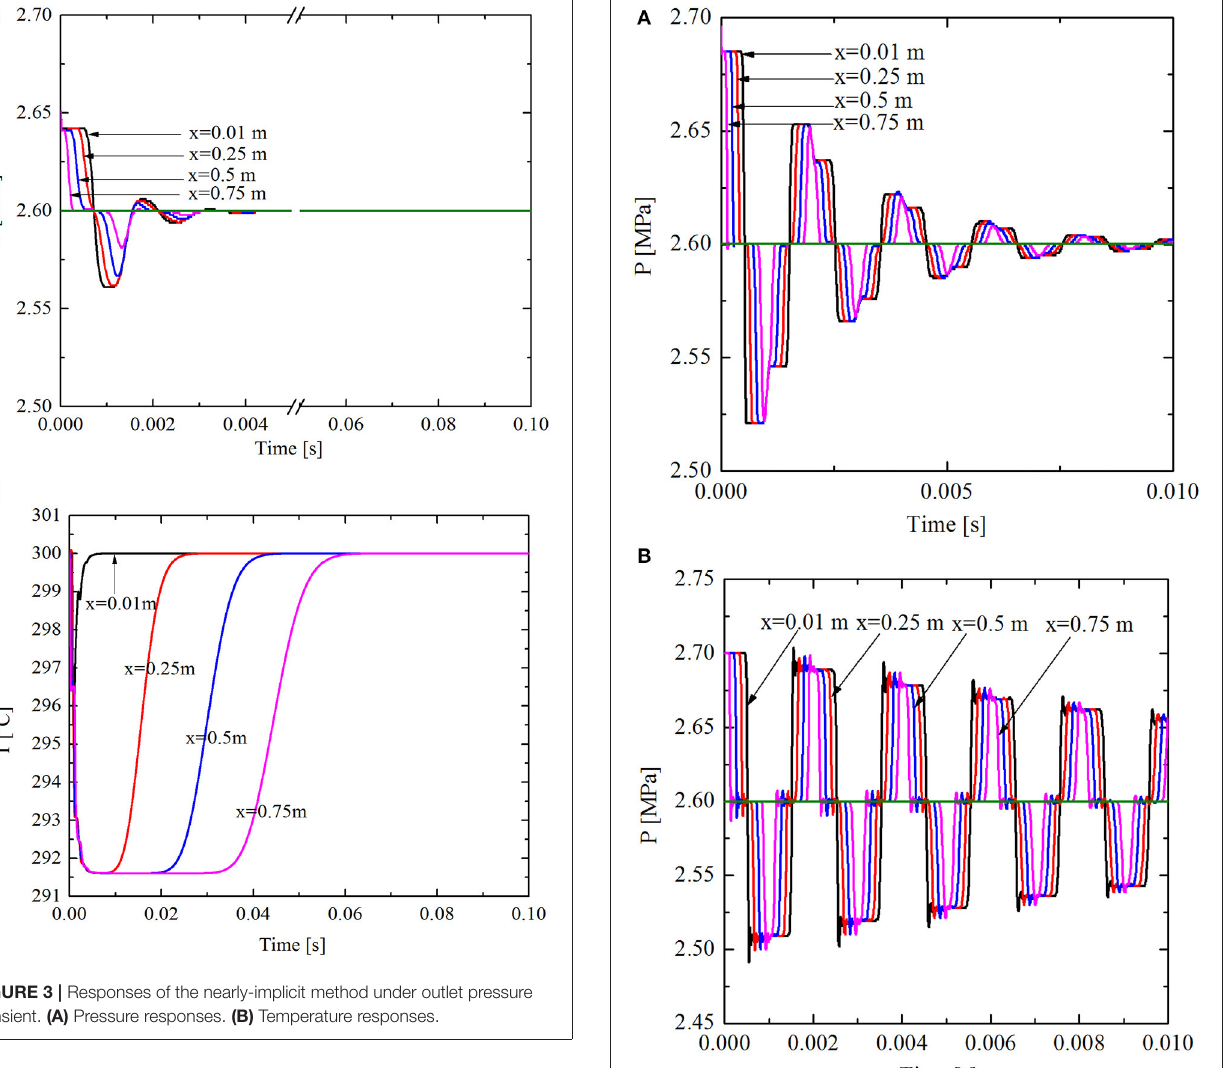
term is explicit. So the expressions of density,